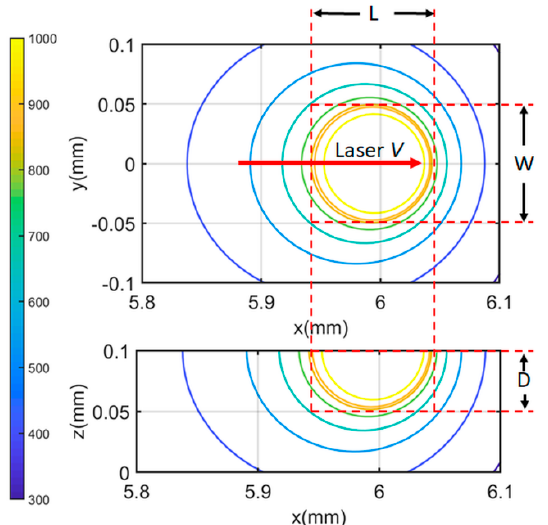
Figure 5. Temperature profiles during a single-track scan of PBMAM with P = 180 W, V = 600 mm/s at ( a ) 0.001 ms ( b ) 0.01 ms ( c ) 0.1 ms ( d ) 1 ms ( e ) 10 ms ( f ) 30 ms. It should be noted that the color bar is corresponding to the temperature contour value in Kelvin. The temperature plots on x - y planes are the temperature profiles at the top boundary; the temperature plots on x - z planes are the temperature profiles at the cross-sectional area along the laser scanning direction. Laser scanning direction is along positive x-direction at y = 0 mm.